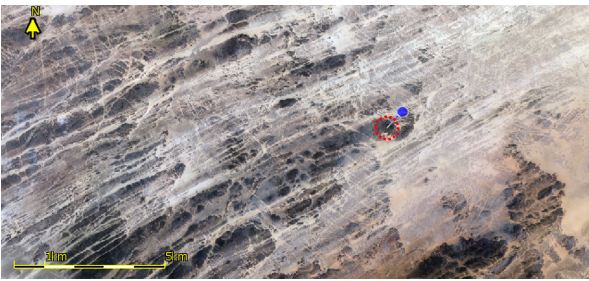
Figure A3. ©Copernicus data (2019). Sentinel-2 natural colour composite showing a stony surface dust source near the border between Chad and Niger in the north. The source emitted dust on 1 December 2015. The location of the pin is latitude 22.2030, longitude 15.2052. A 750m buffer is included in red. Background: European Space Agency Copernicus Sentinel-2 data 2018. Sentinel-2 data are provided under the terms and conditions prescribed by the European Commission’s Copernicus Programme. For detailed information on the data policy, appropriate usage, and citation of Sentinel data, please see: https://scihub.copernicus.eu/twiki/pub/SciHubWebPortal/TermsConditions/TC_ Sentinel_Data_31072014.pdf (last access: July 2018).